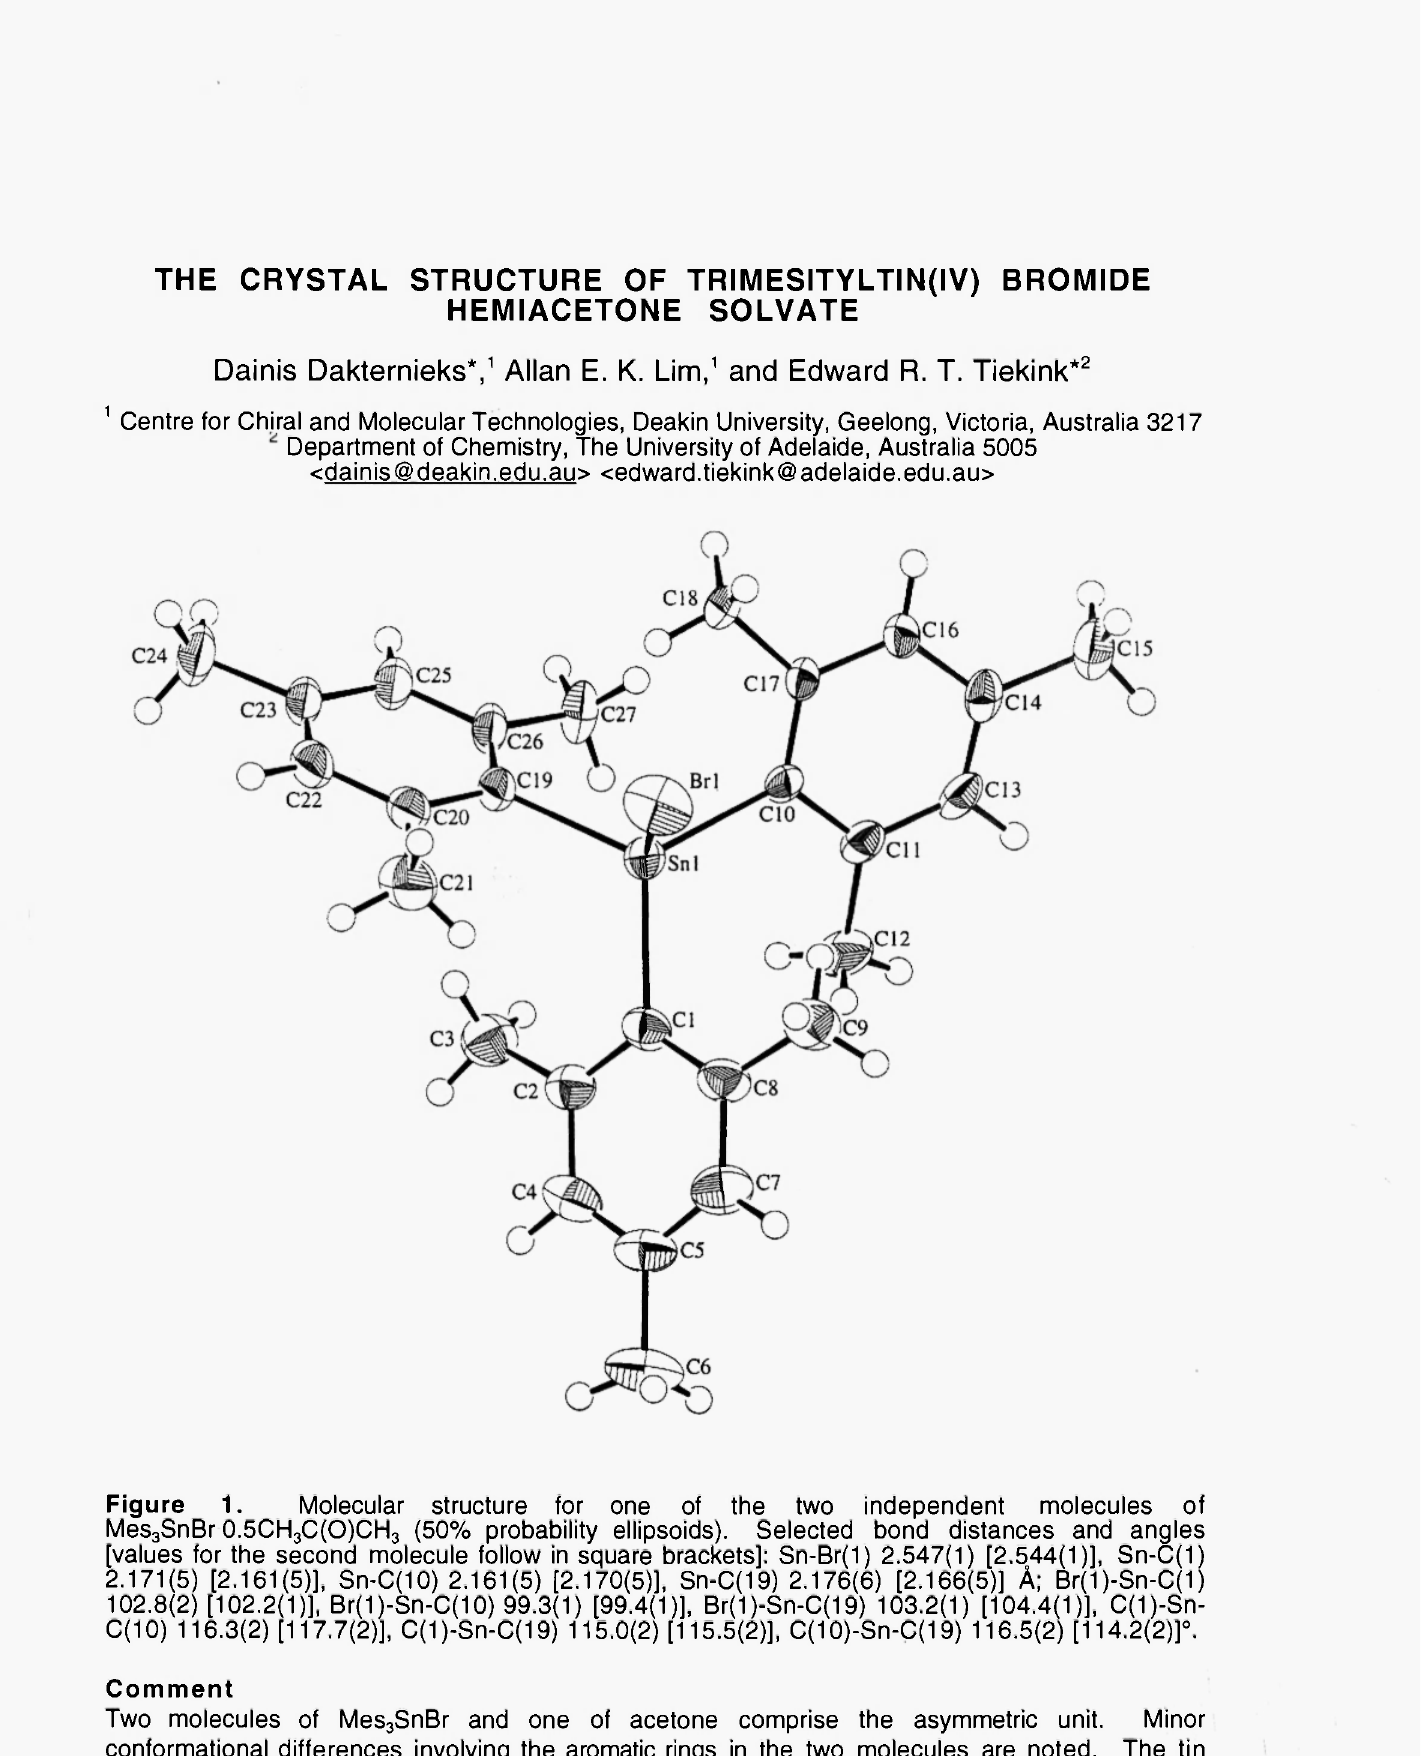
Comment Two molecules of Mes 3 SnBr and one of acetone comprise the asymmetric unit. Minor conformational differences involving the aromatic rings in the two molecules are noted. The tin